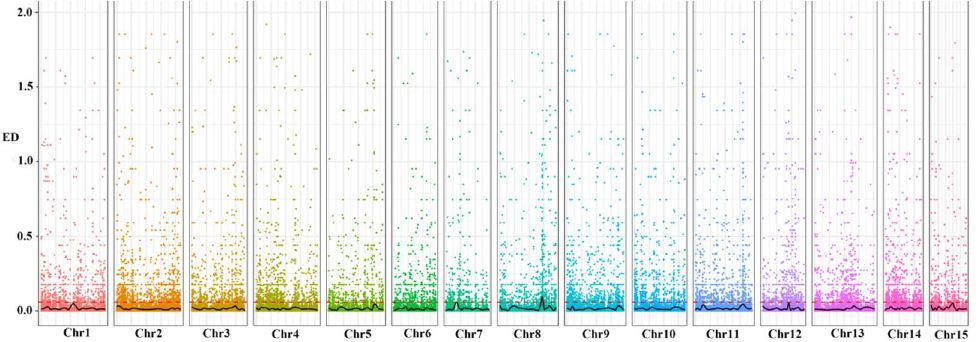
Figure 5. Distribution of ED association values of two bulks of C. vietnamensis on C. oleifera var. chromosomes. Note: the horizontal coordinates are the chromosome names, the different-colored dots represent the ED values of each SNP locus, the black line is the fitted ED value, and the red dashed line represents the significance association threshold. The higher the ED value, the better the association effect of the point.